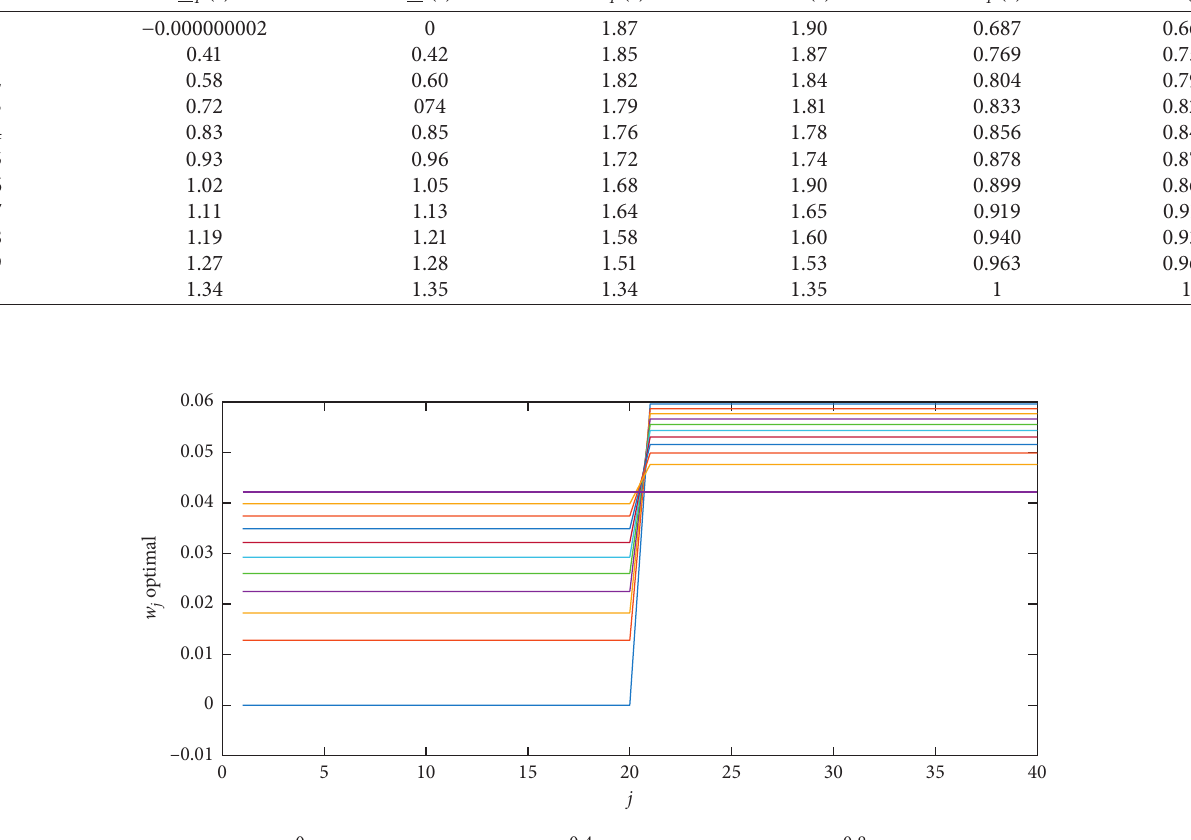
Table 3: Comparison of the exact Z and Z